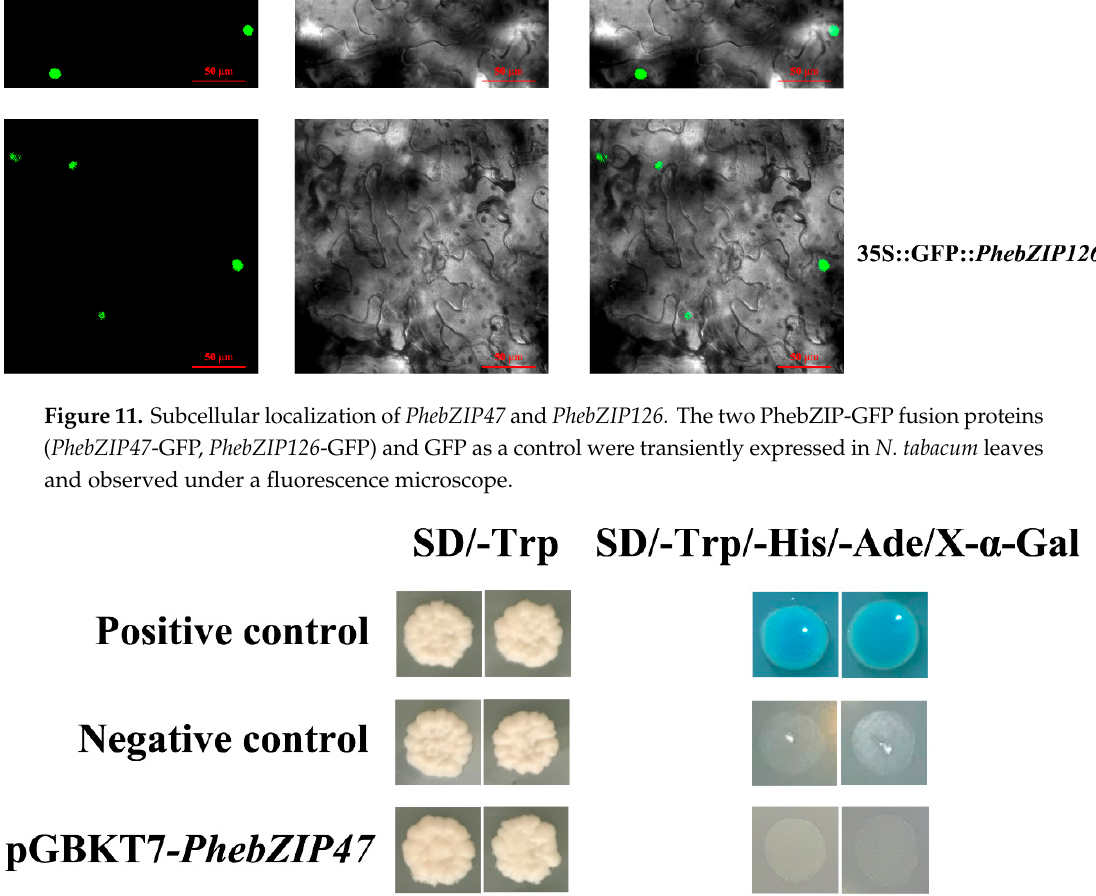
Figure 12. Transactivational analyses of PhebZIP47 in yeast Y2HGold strain. The positive constructs, negative constructs, and fusion constructs were transformed into yeast Y2HGold strain and successively incubated in SD/-Trp media and SD-His/-Ade/-Trp plate supplemented with X-a-GAL.